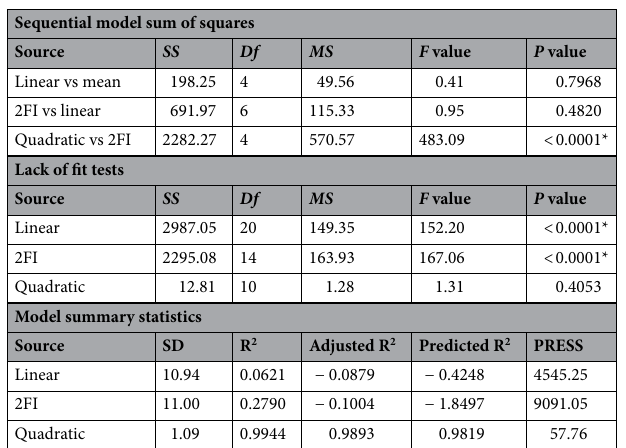
Table 4. Fit summary of the experimental results of CCD for methyl red decolorization (%) by using Scenedesmus obliquus . *Significant values, Df : degree of freedom, PRESS: sum of squares of prediction error, 2FI: two factors interaction, SD: Standard deviation, SS : Sum of Squares, MS : Mean Square.